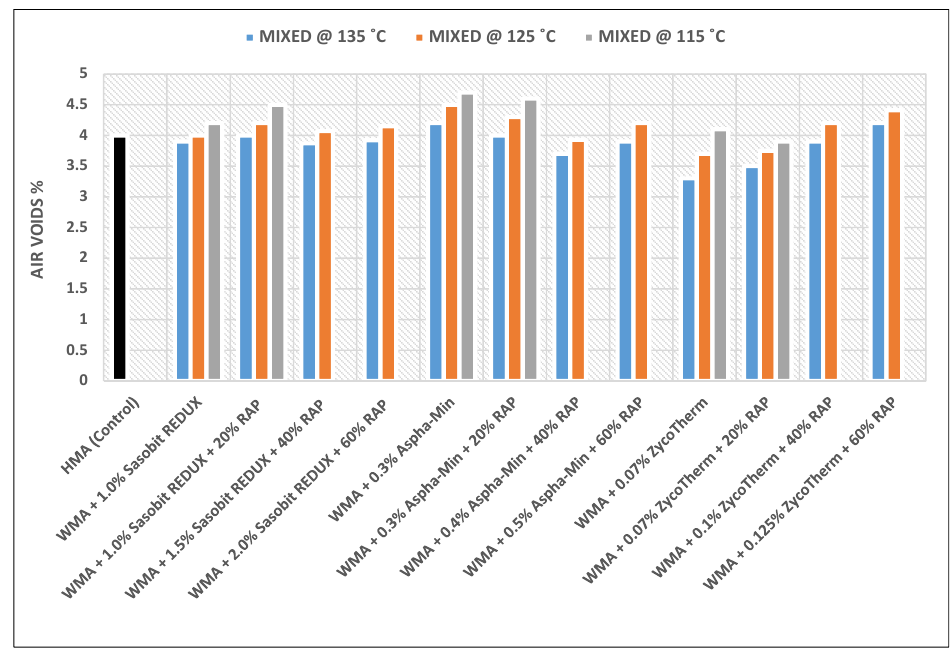
Figure 17. Air content for the modified virgin and recycled WMA mixtures.